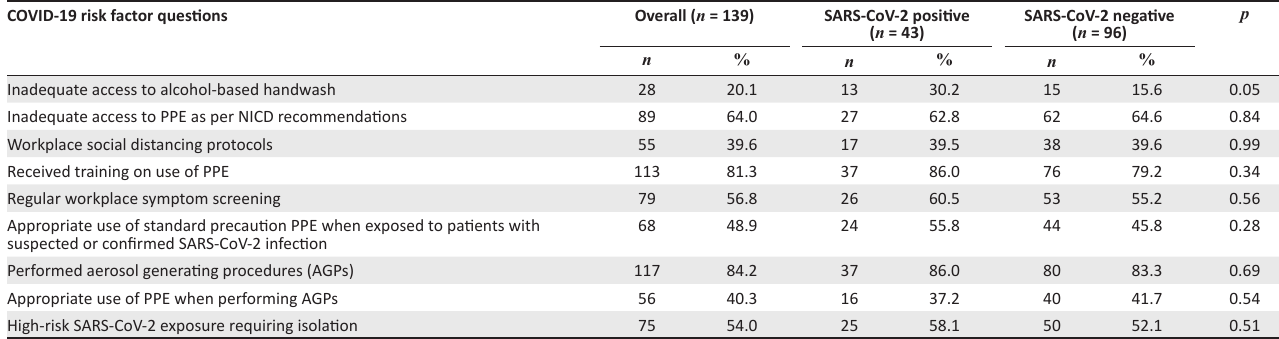
TABLE 3: SARS-CoV-2 infection possible risk factors.